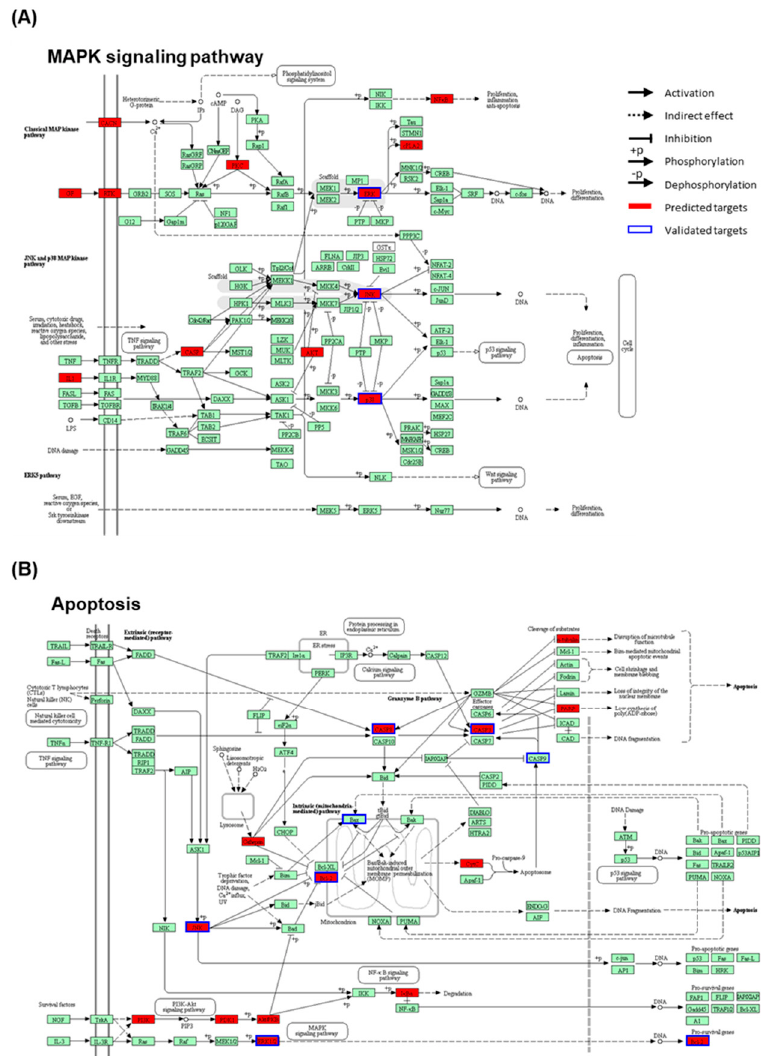
Figure 8. Representation of targets of 3DC2ME in ( A ) MAPK and ( B ) apoptosis pathways. The pathway maps were constructed using KEGG mapper.